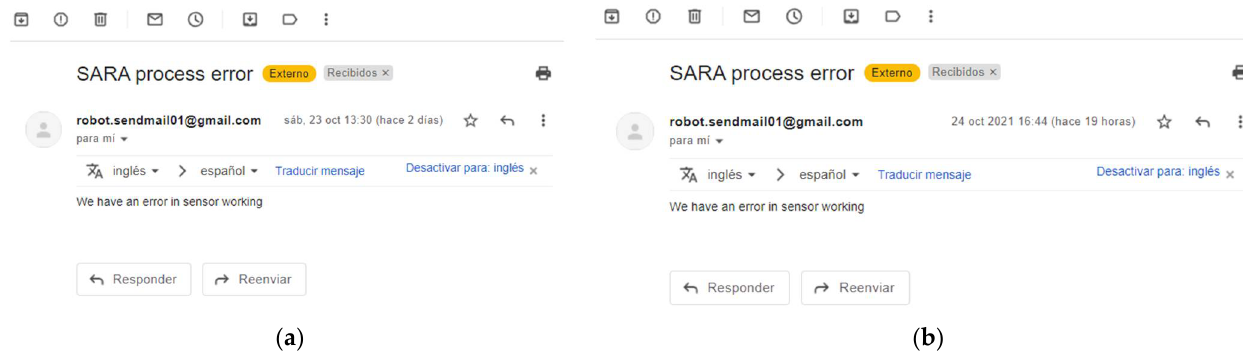
Figure 14 . Email notifications sent by the robot. ( a ) Error 1. ( b ) Error 2. The data capture process over 48 h generated 234 files with an average of 9.35 Mb